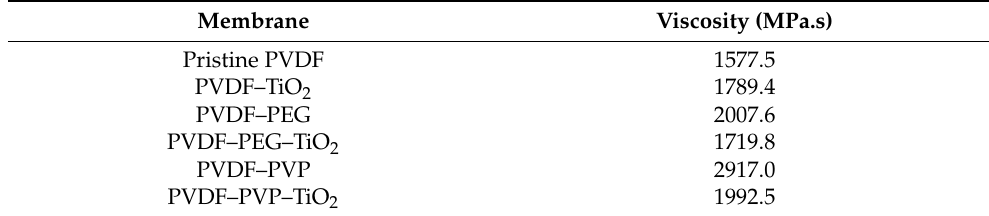
Table 5. Viscosity of membranes’ dope